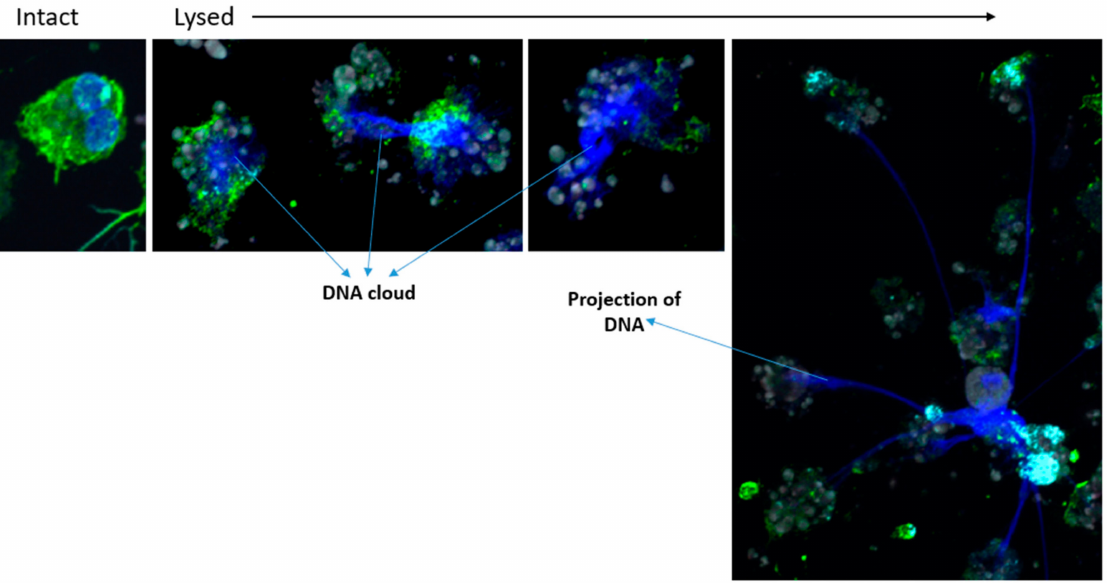
Figure 5. IL3-primed eosinophils on IgG release DNA in the extracellular compartment. Blood eosinophils were primed with IL3 (2 ng/mL) for 20 h and were seeded on coated HA-IgG for 5 h. Eosinophils were stained for an actin regulatory protein, gelsolin (anti-gelsolin; green), filamentous actin (phalloidin, grey), and DNA (DAPI; blue). DNA clouds and projections are stained by